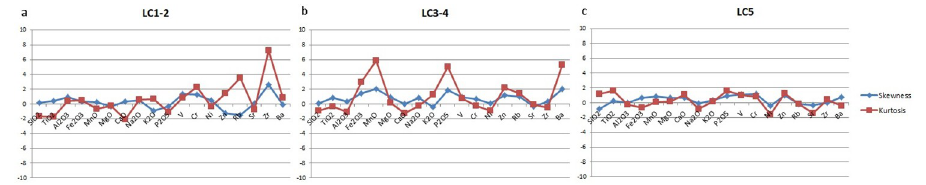
Fig 9. Skewness and kurtosis calculated for each element within the LC1-2 (a), LC3-4 (b) and LC5 (c).